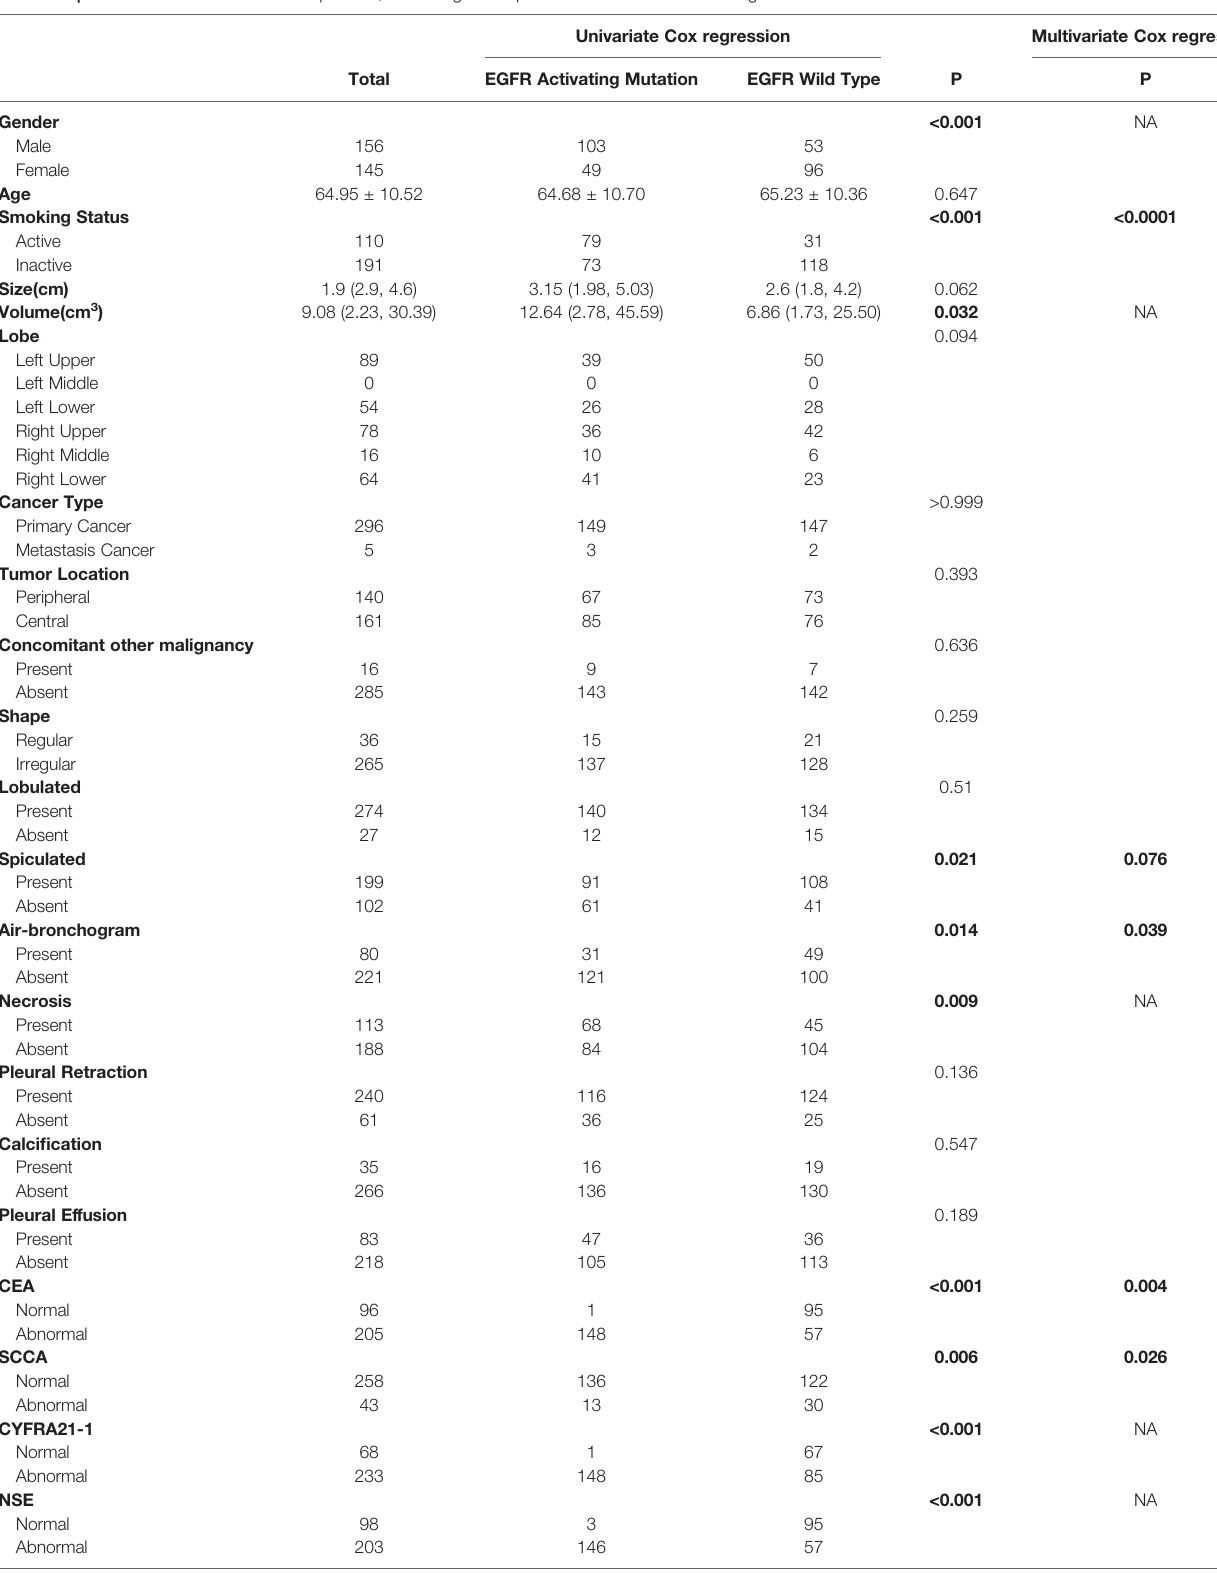
TABLE 1 | Characteristics of 301 NSCLC patients, according to the presence of the EGFR activating